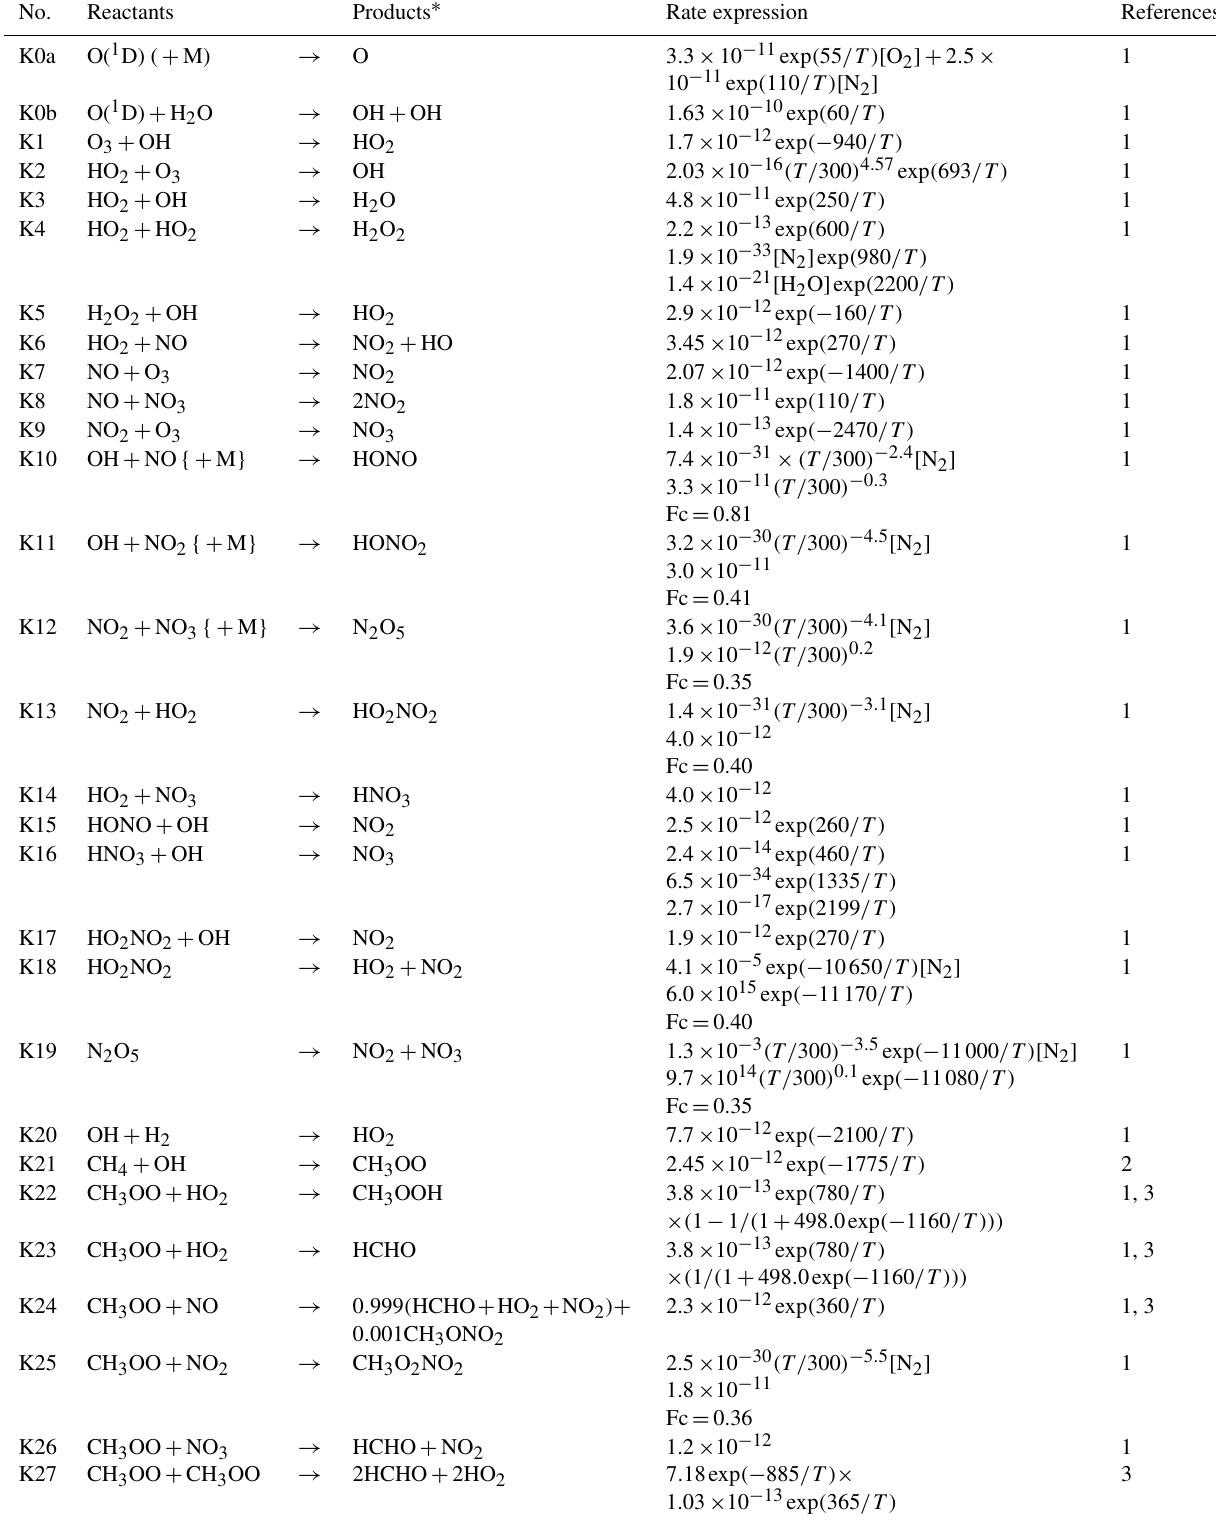
Table 2. Thermal reactions (K) in the MOGUNTIA chemistry scheme.